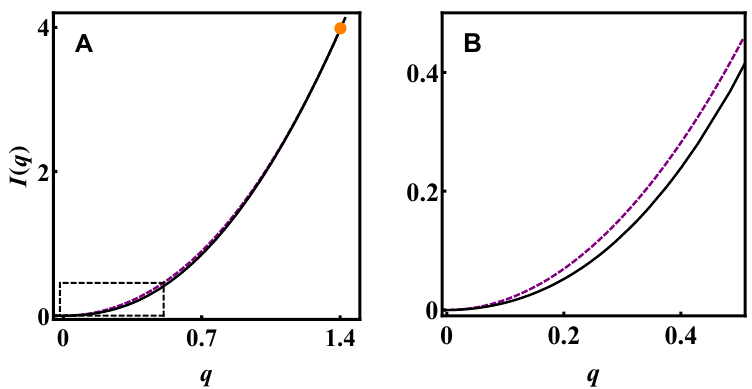
= 0.9 and ℓ − 1 → 0. Panel (B) Figure 6: The rate function I ( q ) of Eq. (13) at ρ 0 s is a closeup of the region marked in panel (A) by a dashed rectangle. The continu- ous black line represents the rate function I ( q ) while the dashed purple curve is the sub-optimal rate function that corresponds to a homogeneous profile (24). I is con- structed from the convex hull of I in the parameter space ( ρ , q ) , see main text. The H 0 rate function has a jump in its second derivative at the orange point where these two rate functions are tangent. This point corresponds to the boundary of the traveling band phase denoted by the orange curve in Fig. 5